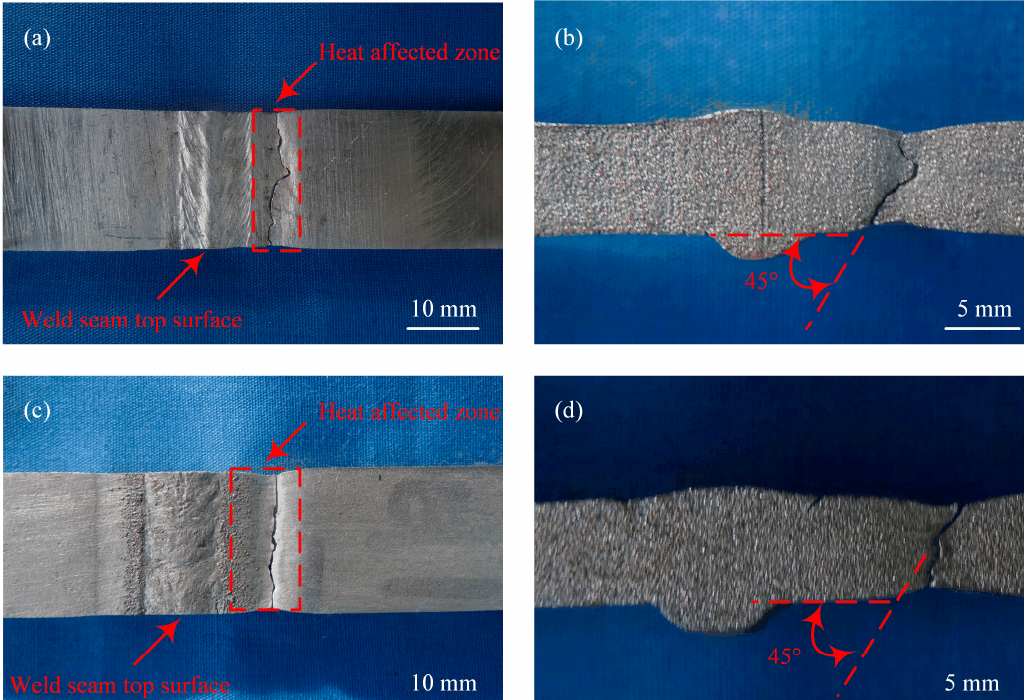
Figure 10. Fracture locations of the tensile test samples. ( a ) Top surface of laser-CMT hybrid welded joint; ( b ) cross-section of laser-CMT hybrid welded joint; ( c ) top surface of plasma-CMT hybrid welded joint; ( d ) cross-section of plasma-CMT hybrid welded joint.